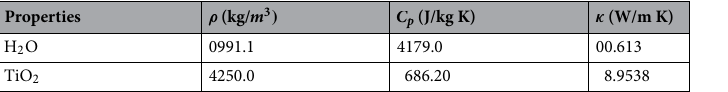
Figure 1. Flow configuration.